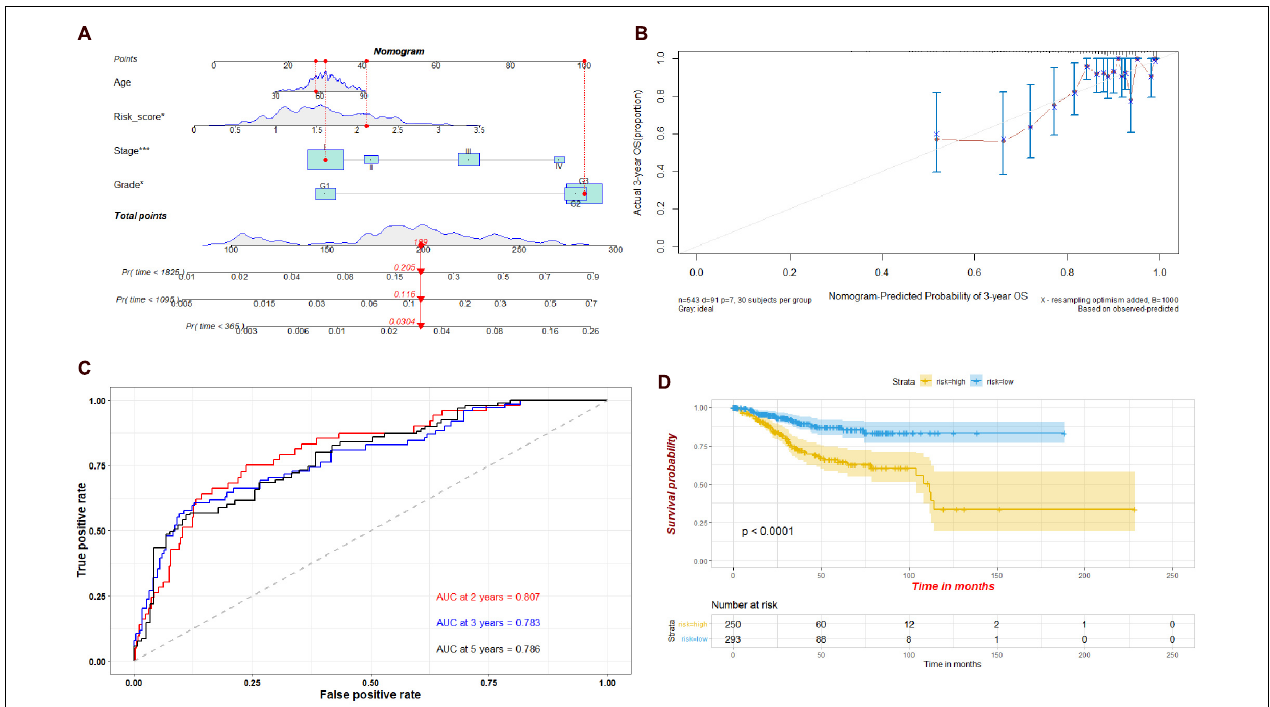
FIGURE 10 | (A) Nomogram of the risk scores of the four hub genes, age, stage, and grade. (B) Calibration curve for the nomogram. (C) Time-dependent ROC plot of the risk model used in the nomogram. (D) Kaplan-Meier plots of the risk model used in the nomogram.